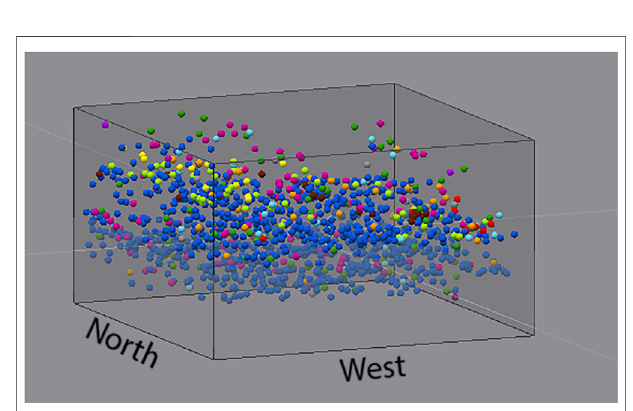
FIGURE4| 3Dmapofallfossiloccurrenceswithinourstudyarea,color- coded by taxonomic category as shown in the legend for Figure 1D .